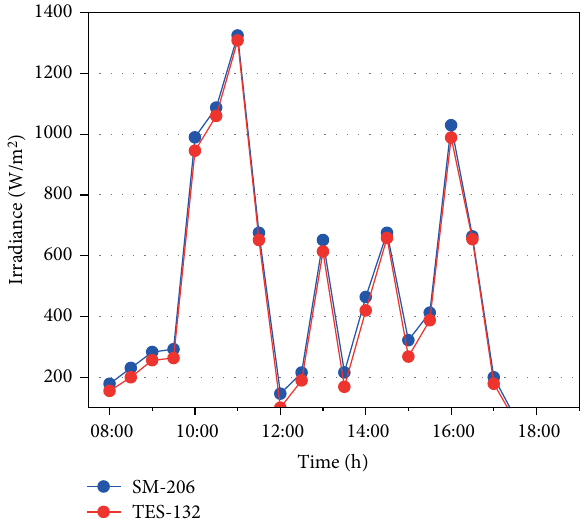
Figure 4: Variation of air and module temperatures ( 𝑇 a , 𝑇 m ) and relative humidity ( 𝑅 h